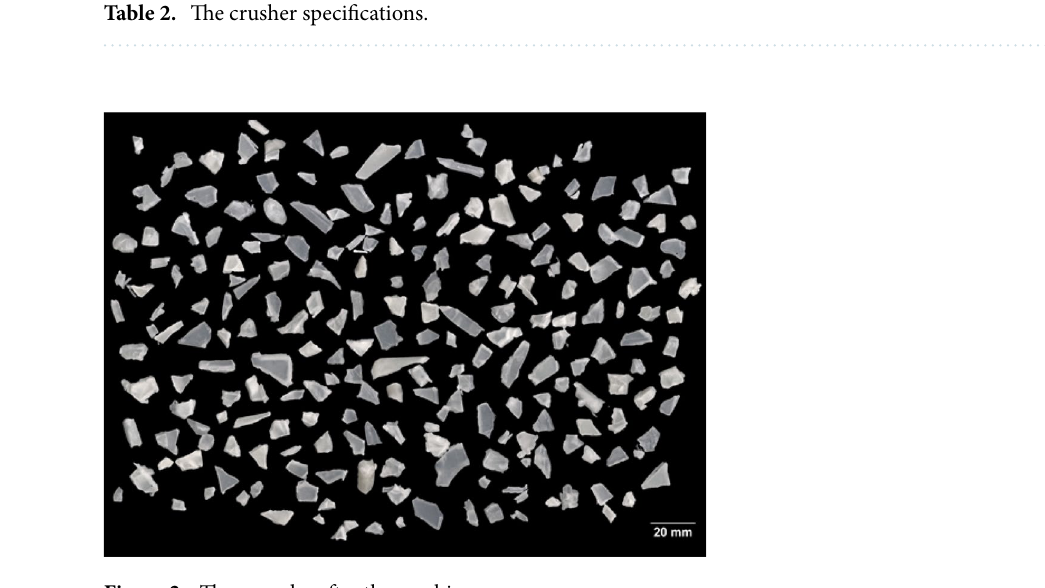
Figure 2. The granules after the crushing process.